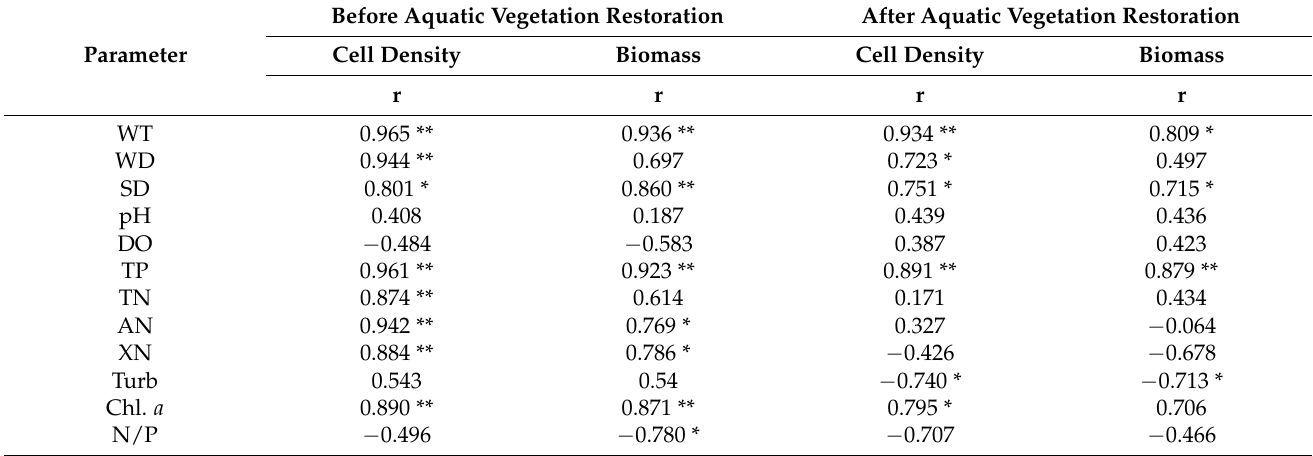
Table 3. Relationship between the cell density and biomass of the phytoplankton and environmental factors before and after the aquatic vegetation restoration.